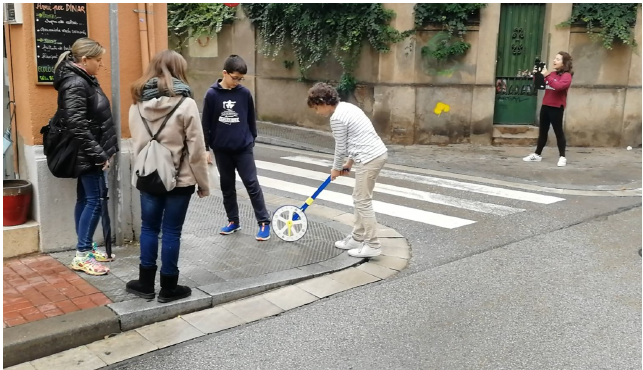
Figure 5. Fieldwork measuring the width of the sidewalk mounted by cars when